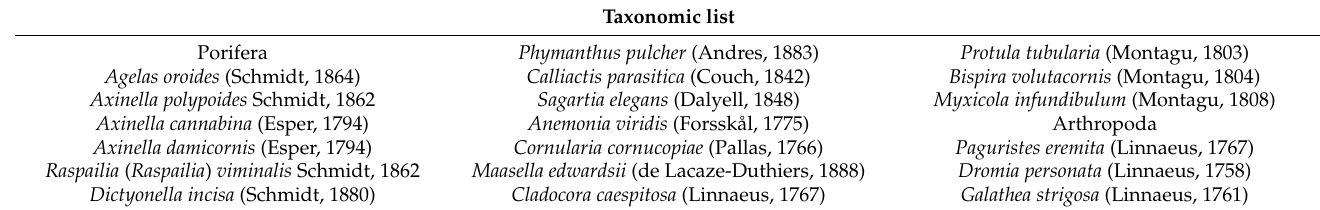
Table 2. List of species determined for the present